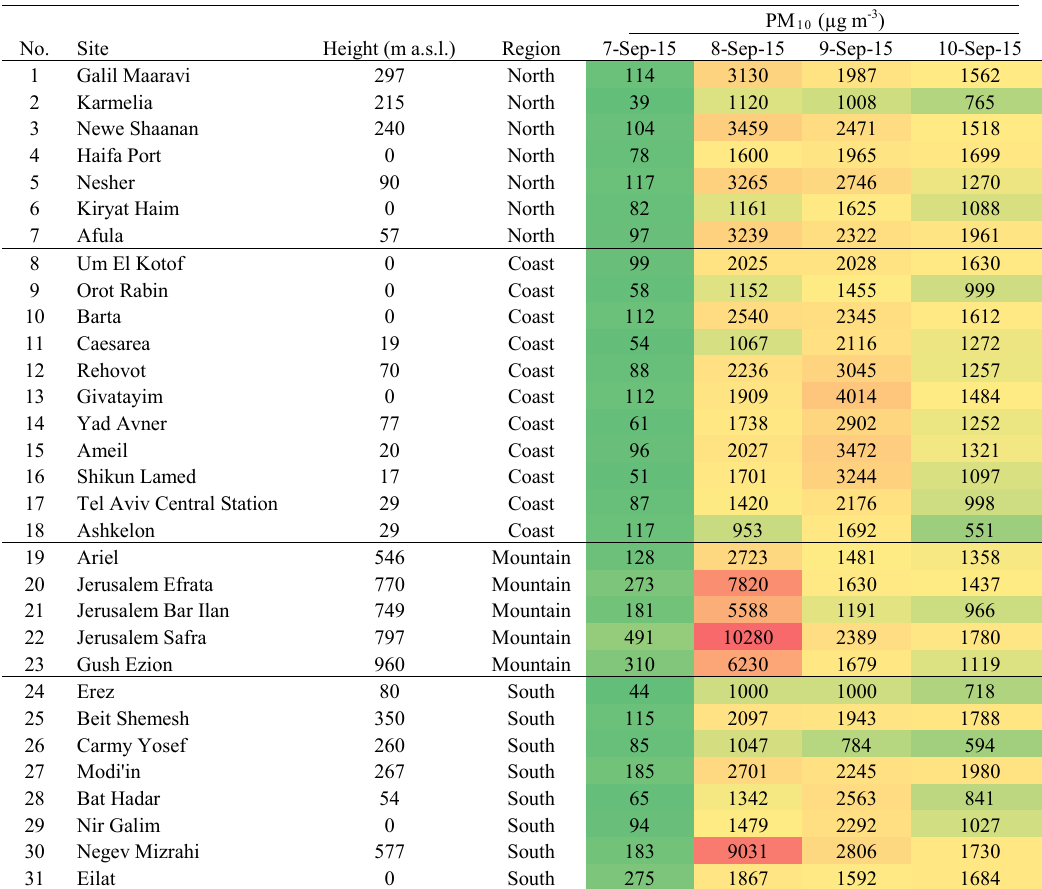
Table 6. Hourly maximum concentration of PM 10 , collected from 31 monitoring sites, between 7 and 10 September 2015. The values are ranked from low (dark green) to high (dark red) values.